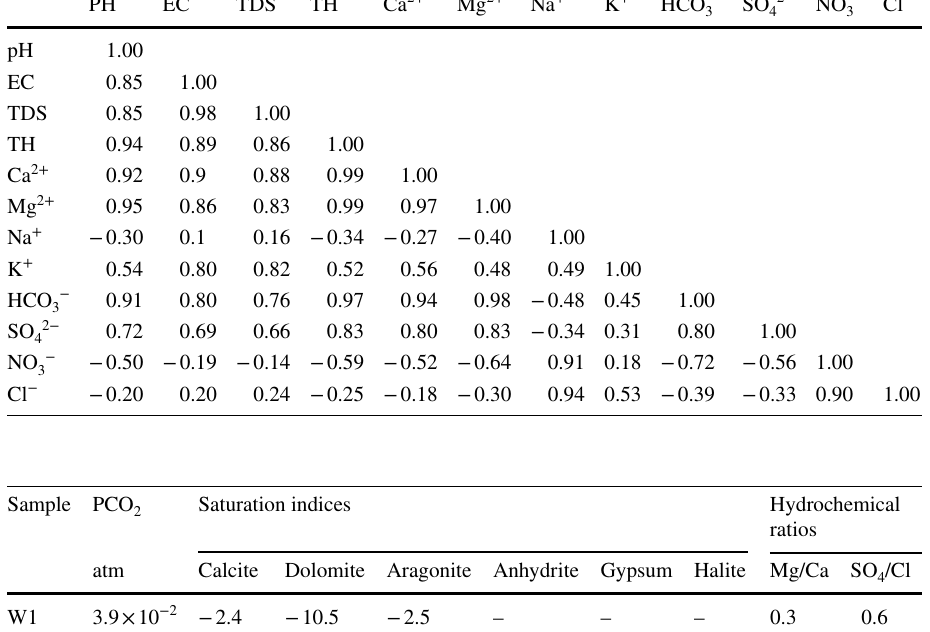
Table 3 Pearson’s correlation matrix for selected physicochemical parameters of the groundwater samples (correlation coefficients ≥ 0.60 are in bold)